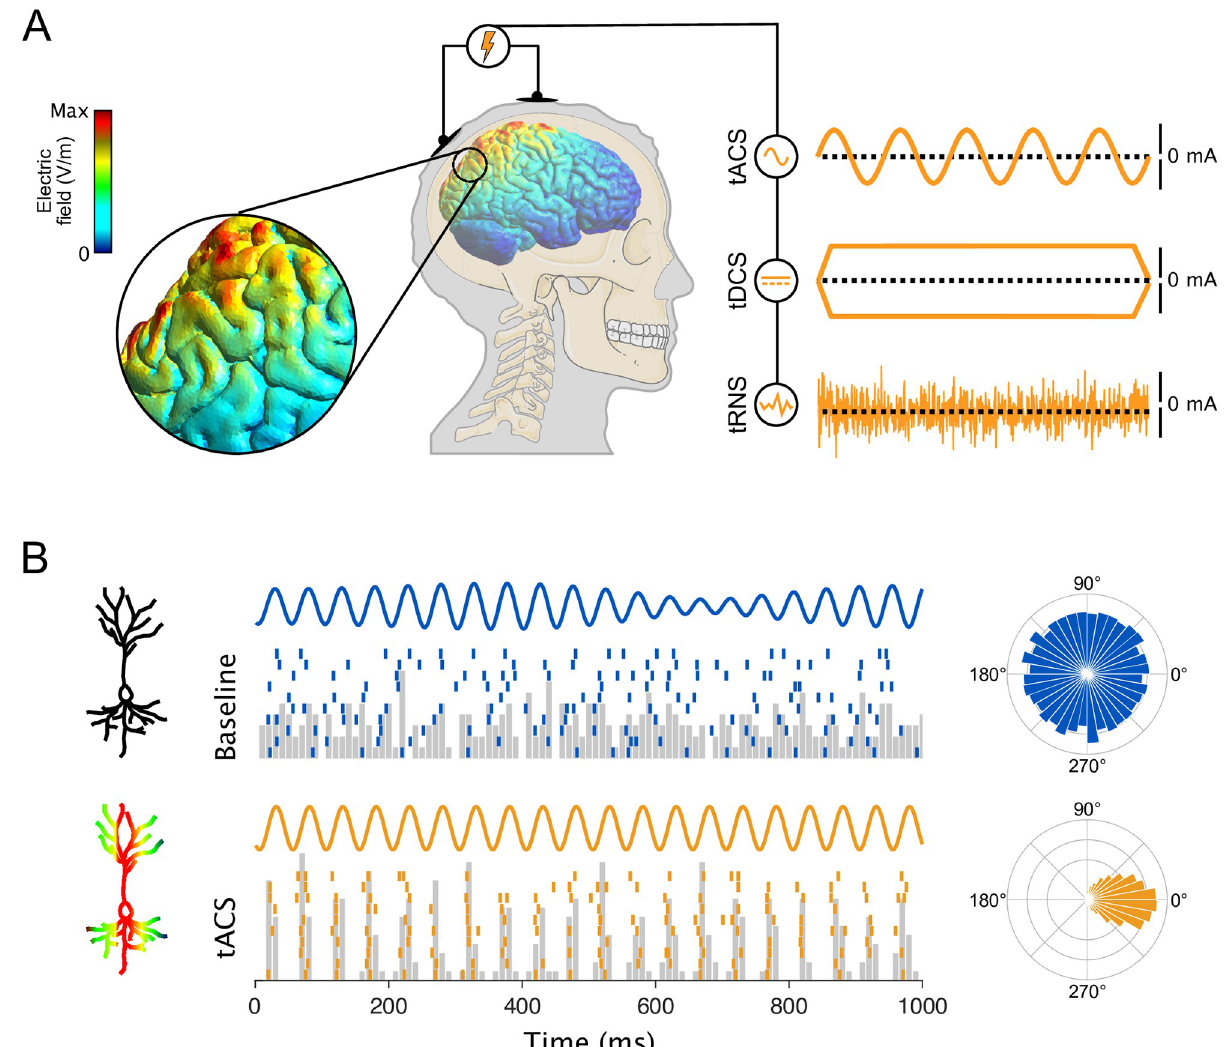
Fig 1. Modern tES uses battery-powered stimulators to alter brain activity. (A) To create intracranial electric fields, weak currents are applied to the user’s scalp. Different types of tES can deliver as different current waveforms, including tACS, tDCS, and tRNS. (B) Despite some early skepticism, it is now clear that these fields do affect the activity of individual neurons. Each tick indicates the time of an action potential recorded from a basal ganglia neuron in an awake monkey. Without stimulation, the neuron’s activity is disorganized and arrhythmic; the timing of the spikes is unrelated to the phase of an ongoing brain oscillation (blue trace). During tACS, the neuron becomes entrained to the stimulation and fires during a specific part of its cycle. The average activity over ten 1-s segments is shown in gray. The preferred phases of the neuron in each condition are shown in the polar histograms (right). See [4] for experimental details. The head in Fig 1 was adapted from a CC-BY 3.0 licensed illustration by Servier/BioIcons. The electric fields in the brain were generated with SimNIBS [5]. tACS, transcranial alternating current stimulation; tDCS, transcranial direct current stimulation; tES, Transcranial electrical stimulation; tRNS, transcranial random noise